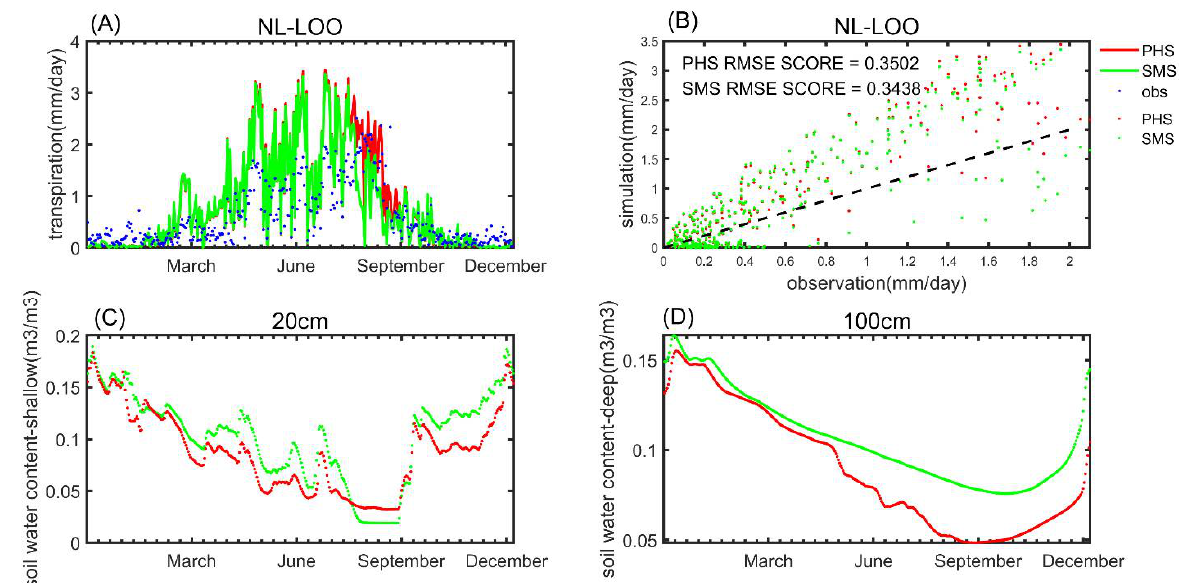
Figure 5. Transpiration (mm/day) and soil water content (m 3 /m 3 ) at NL-LOO (the site name) in 2012. ( A ) seasonal variation in transpiration; ( B ) comparison between simulated transpiration and SAPFLUX data; ( C ) soil water content simulated by PHS and SMS at shallow soil layer (20 cm); ( D ) soil water content simulated by PHS and SMS at deep soil layer (100